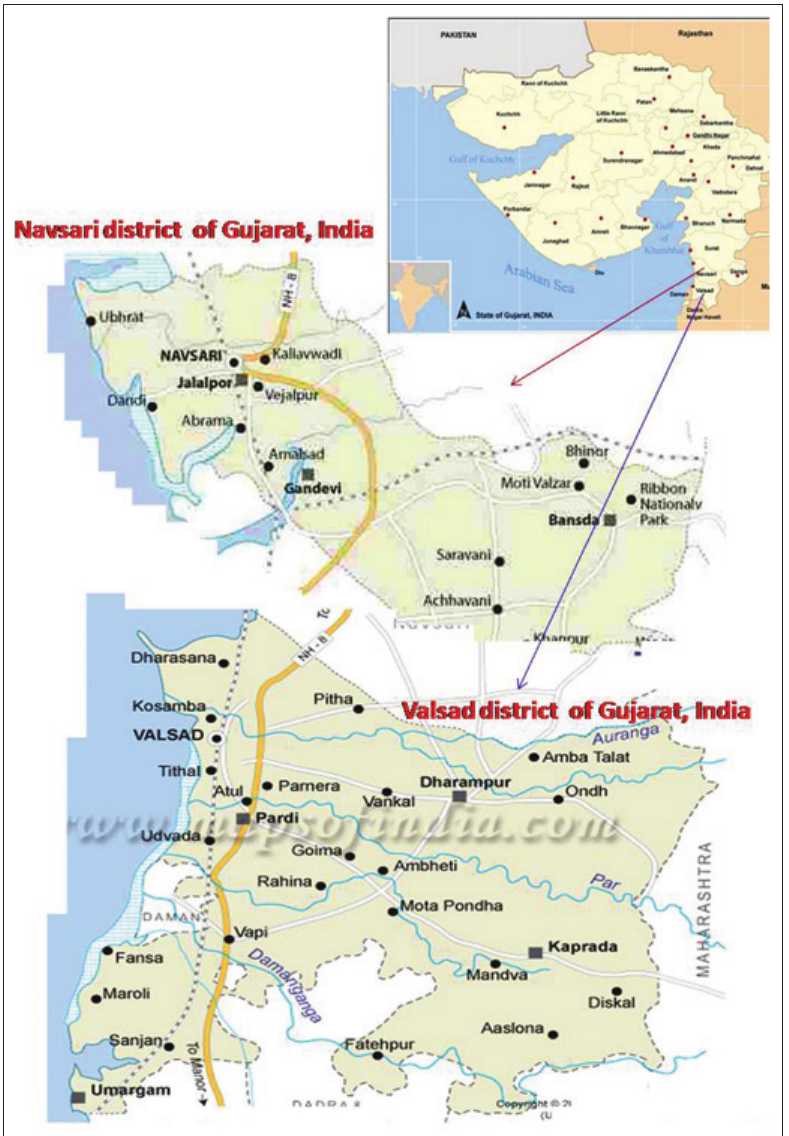
Figure-1: Area covered under the research